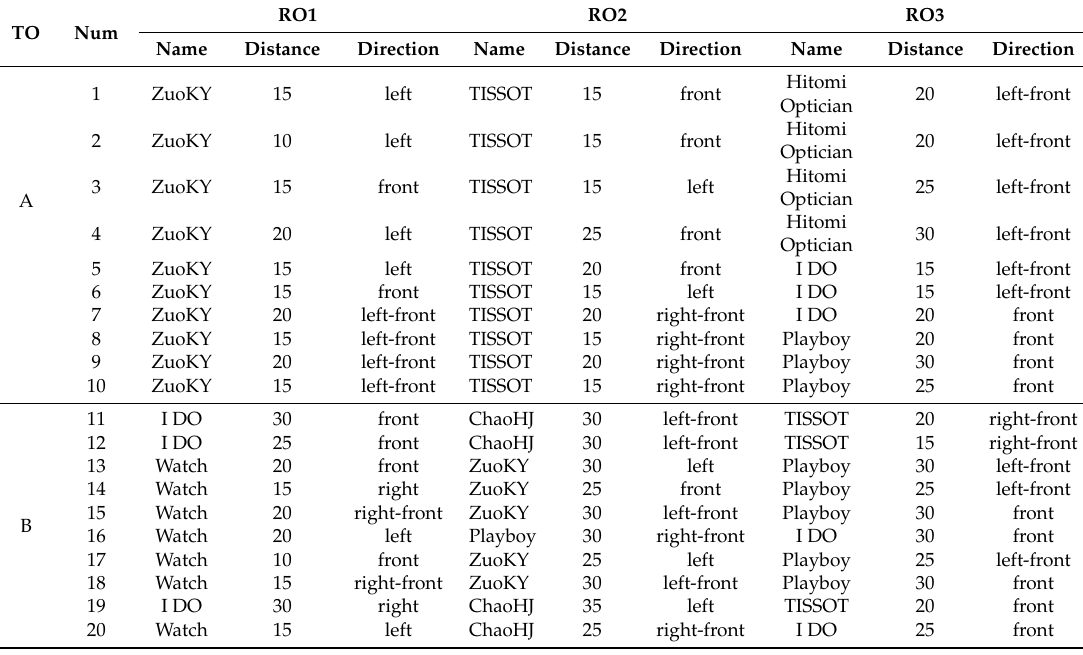
Table 2. Locality description with three